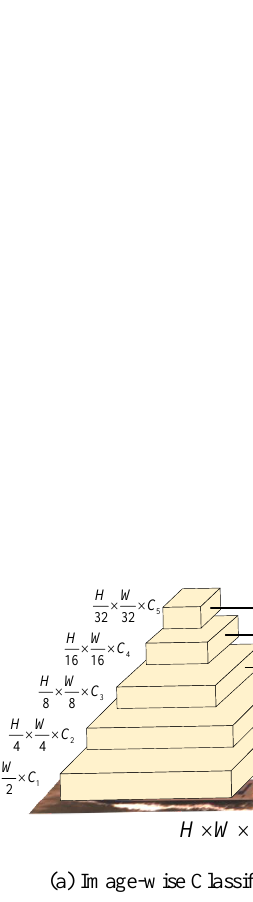
Figure 3. CNN feature extractor networks. Different feature extractor networks are proposed for three classification-based downstream tasks. For ( a ) image-wise classification and ( b ) pixel-wise classification of tasks, the top-down fusion is performed on multi-scale feature maps to obtain the high-resolution feature maps with semantic information. For ( c ) semantic segmentation task, dilated convolution is applied on deep features to improve the receptive field of the convolution